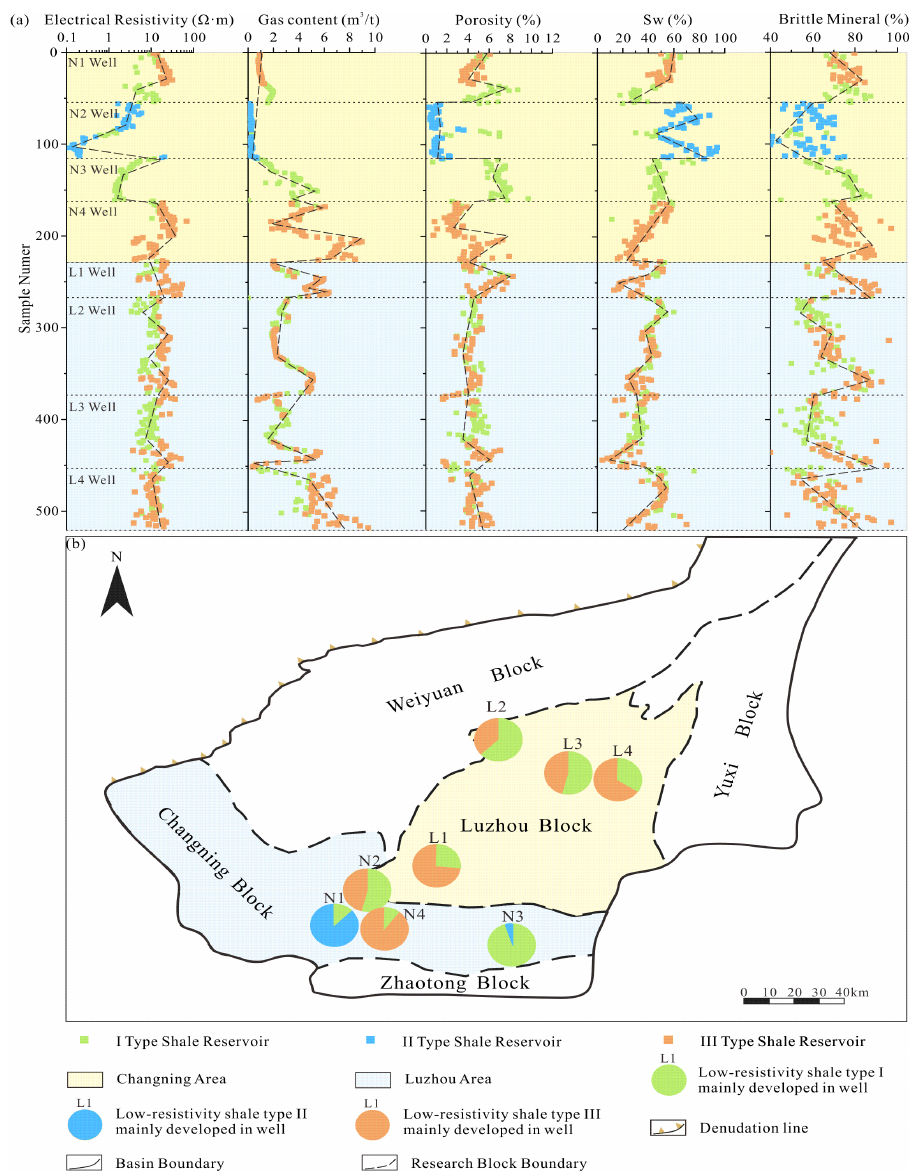
Figure 13. Relationship among reservoir parameters of three low-resistivity shale types ( a ) and the distribution of three types of low-resistivity shale at the Changning block and Luzhou block ( b ).